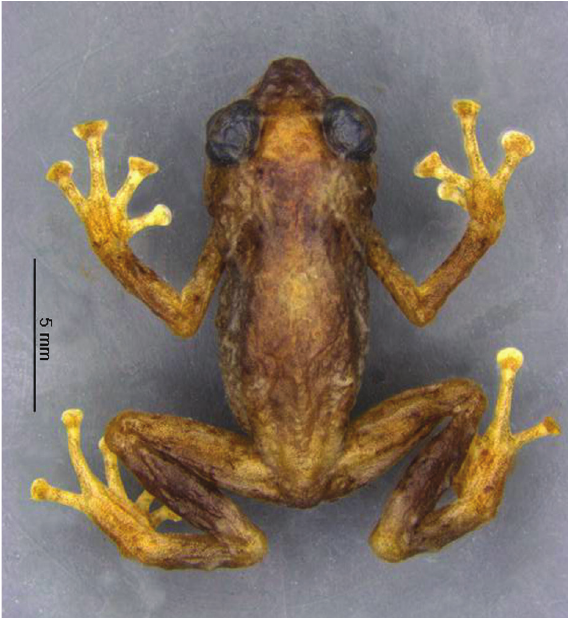
Figure 5b. Preserved holotype of Choerophryne multisyllaba sp. n. in ventral view.